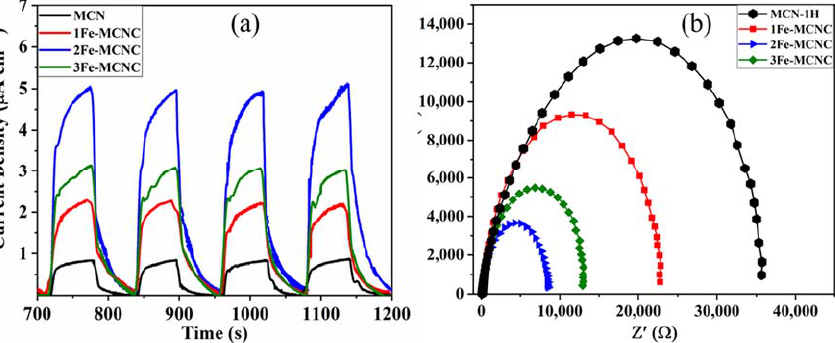
Figure 8. ( a , b ) Transient photocurrent responses and Nyquist plots of MCN and Fe-MCNC nanostructures.